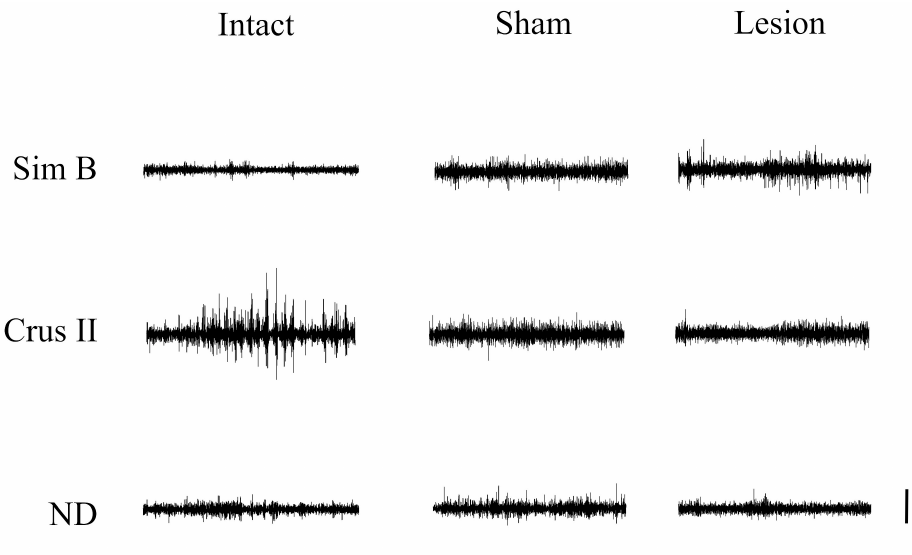
Figure 1. Representative traces of multiunit activity of three seconds were obtained during the grooming behavior of animals from intact, sham, and lesion groups in the Sim B and Crus II lobes and the dentate nucleus. Horizontal calibration: 500 ms. Vertical Calibration: 2 mV.